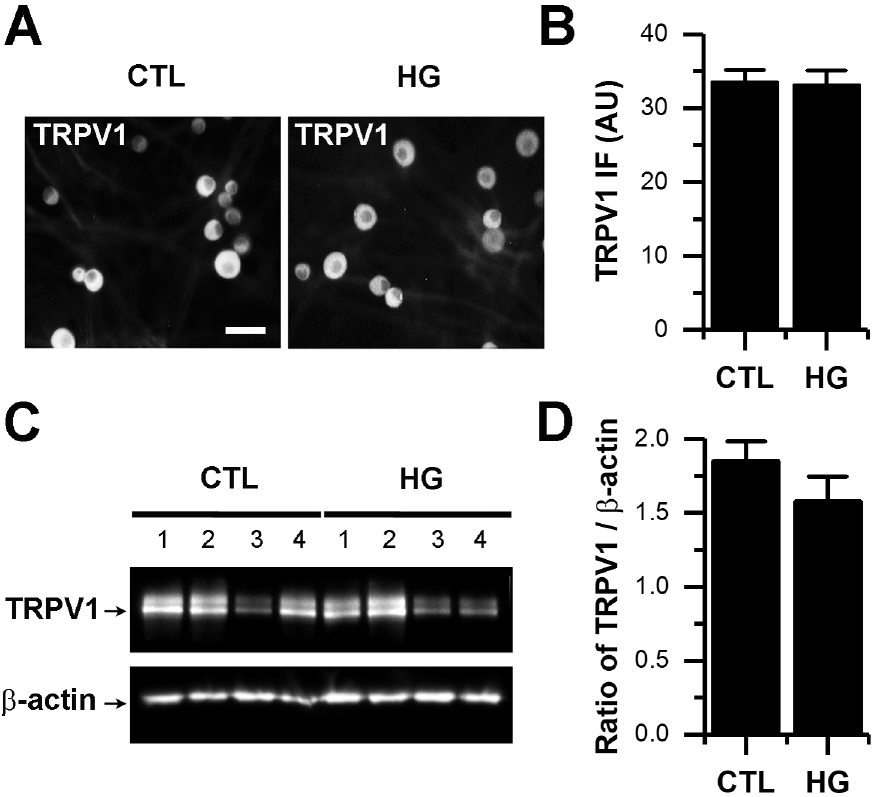
Fig 8. High glucose did not increase expression of TRPV1 channels. A, representative images immunocytochemistry for the detection of TRPV1 protein in cultured DRG maintained in either control (CTL) or high glucose (HG) conditions. B, bar graph summarizes mean pixel intensity for CTL (n = 71; HG, n = 51). C, western blots showing TRPV1 and β -actin expression in 4 independent samples (per treatment) of cultured DRG neurons exposed to either CTL or HG for 10 days. B, bar graph summarizes the ratio of TRPV1/ β -actin per treatment. All data are represented as mean ± SEM. Scale bar in A represents 30 μ m. Statistical analysis by Mann – Whitney test; no significant differences were found between treatments (B-D). AU, arbitrary